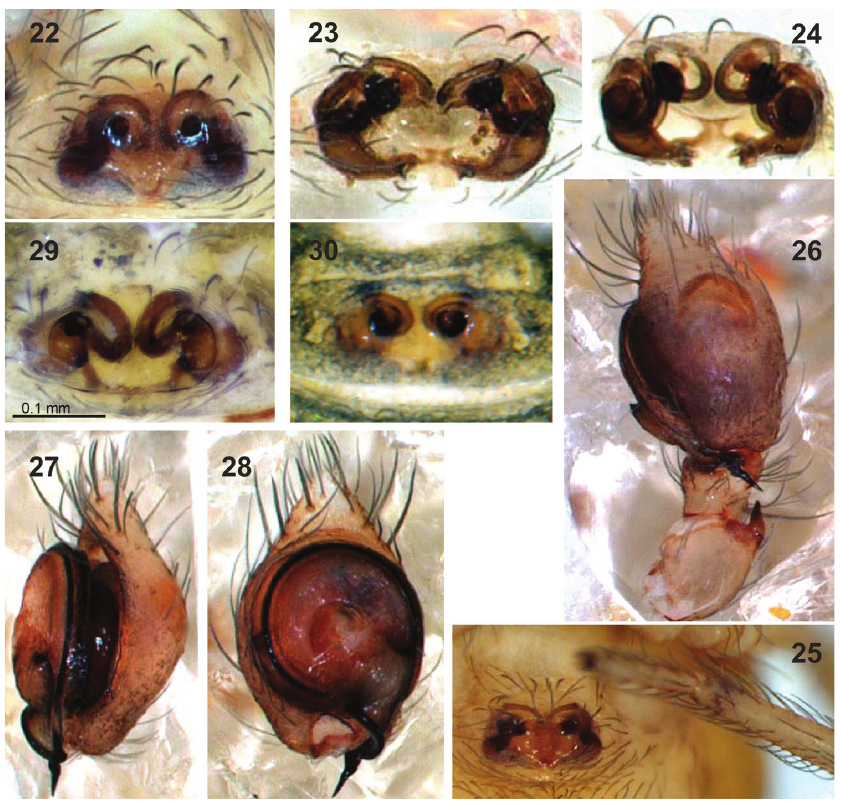
Figures 22–30. Copulatory organs of Lathys ankaraensis sp. n. ( 22–28 ), L . humilis (from Turkey 29 ) and L . nielseni (from Finland 30